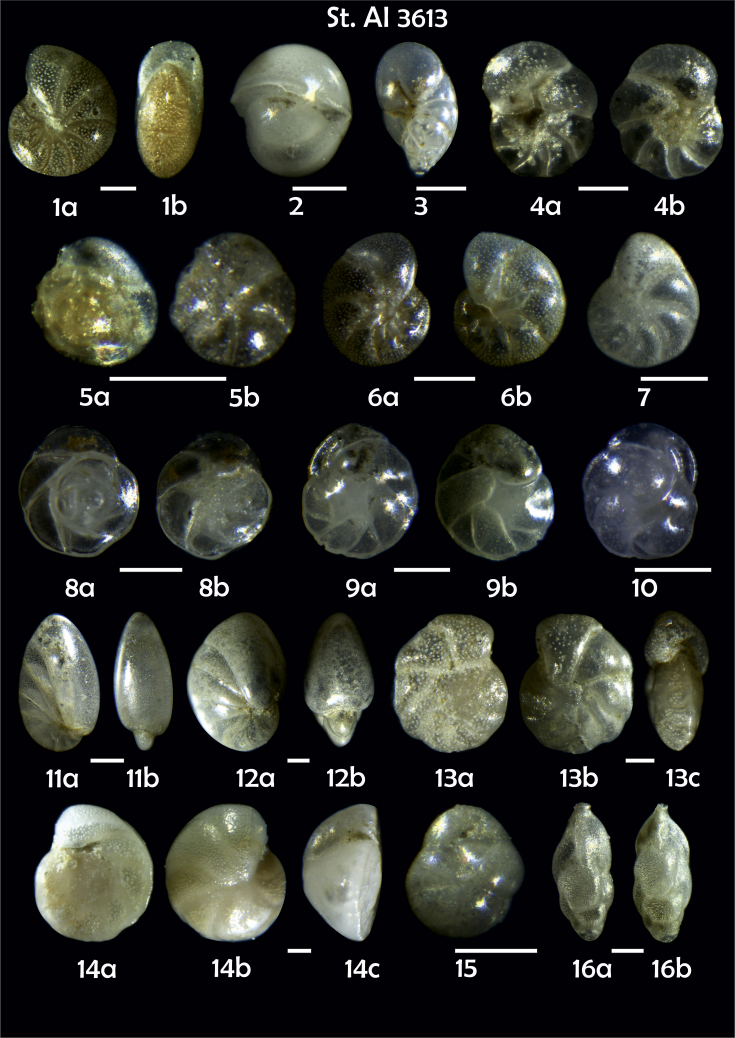
Station 36131Melonis barleeanus,a side view, b apertural view. 2Pullenia bulloides. 3Robertinoides bradyi.4Rosalina sp. cf. R. vilardeboana?, a umbilical view, b spiral view. 5Alabaminella weddellensis, a spiral view, b umbilical view. 6Astrononion stelligerum, a, b side view. 7Elphidium subarcticum. 8Gavelinopsis praegeri, a spiral view, b umbilical view.9Cassidulina teretis, a apertural view, b lateral view. 10C. reniforme. 11Nonionella turgida, a lateral view, b apertural view. 12Nonionella sp.?. 13Cibicidoides sp. cf. C. pseudoungeriana?, a umbilical view, b spiral view, c apertural view. 14Cibicides refulgens,a umbilical view, b spiral view, c apertural view. 15Globocassidulina subglobosa.16Trifarina fluens,a, b lateral view. 17T. angulosa, a, b lateral view. 18Fissurina sp. 19F. squamosoalata. 20Oolina acuticosta. 21Quinqueloculina seminula. Scale 100 μm.